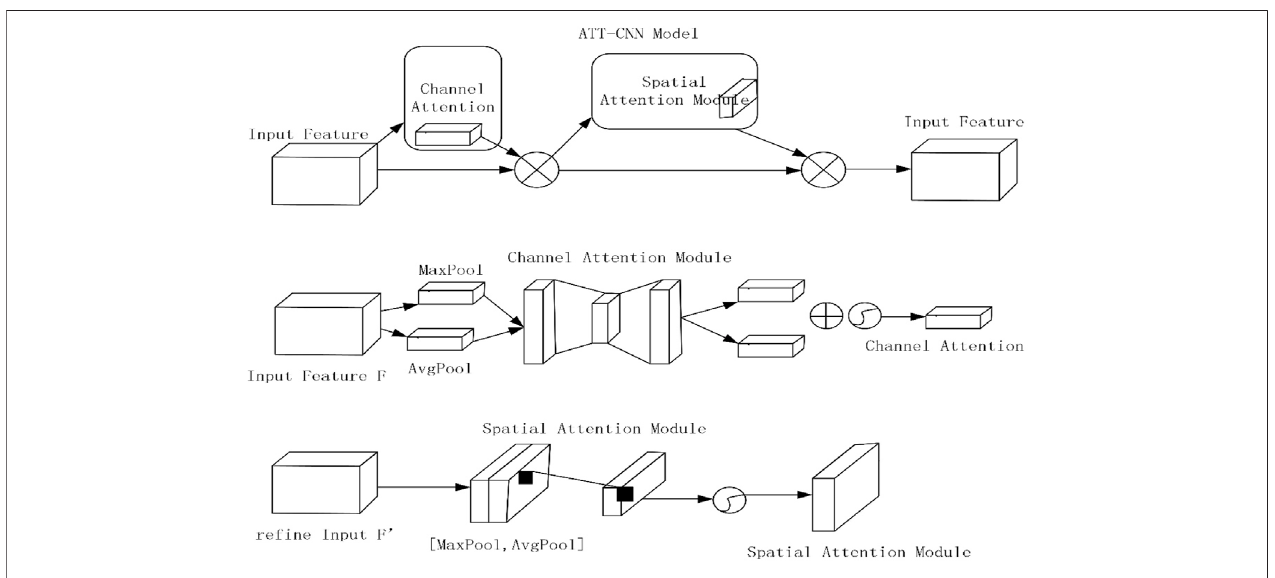
FIGURE 1 | Model of